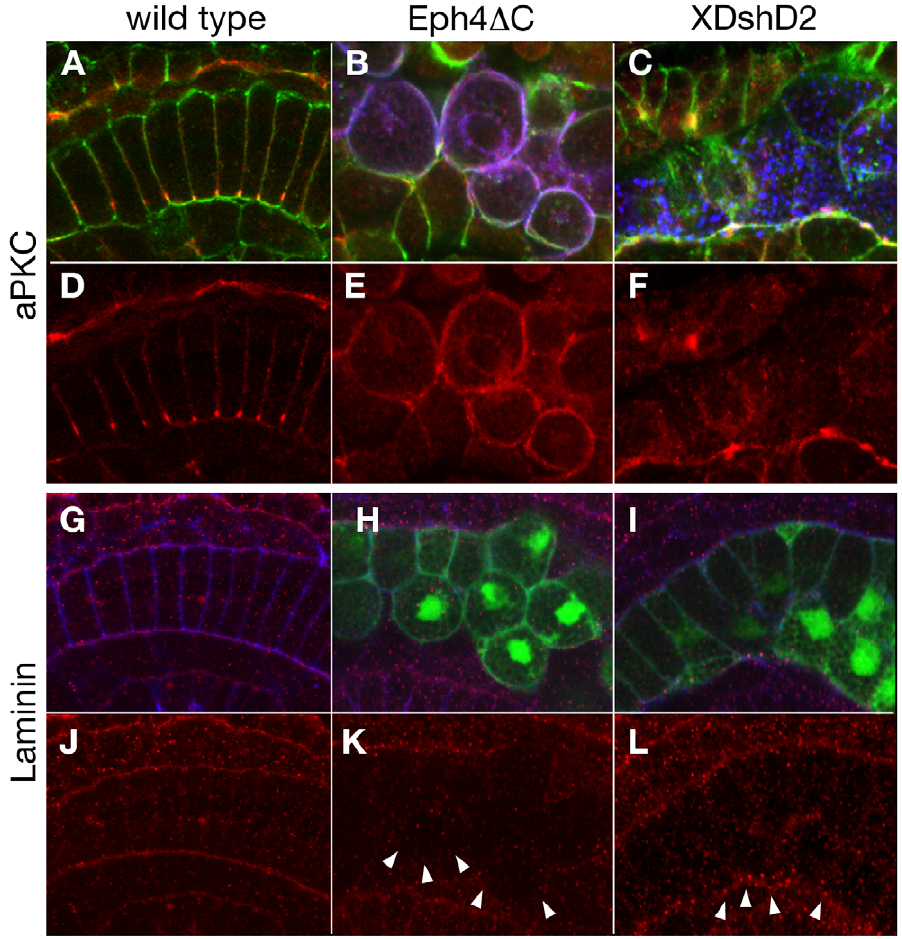
Figure 5. Misexpression of Eph4 D C but XDshD2 altered dorsovasal polarity of notochord cells. Confocal sagittal section images of middle-late tailbud stage embryos with wild-type (A,D,G,J), Eph4 D C-expressing (B,E,H,K), and XDshD2-expressing (C,F,I,L) notochord cells, triple- stained with myc-antibody for Eph4 D C or XDshD2 (blue in B and C), antibodies for aPKC (red in A–F) or Laminin (red in G–L) and phalloidin for actin (green in A–C, blue in G–I). All images are lareral view with anterior to the left. Cells expressing XDshD2 and Eph4 D C were also detected by co- misexpressed EGFP signal (green in H and I, respectively). Note that Eph4 D C-expressing notochord cells are segregated from wild type cells and display aPKC on the entire cell surface with no detectable polarity (B,E) and less evident laminin accumulation (arrowheads in K). XDshD2-expressing notochord cells are also segregated from wild type cells but preserve a ventral accumulation of aPKC (C,F) and perinotochordal accumulation of laminin. (arrowheads in L).